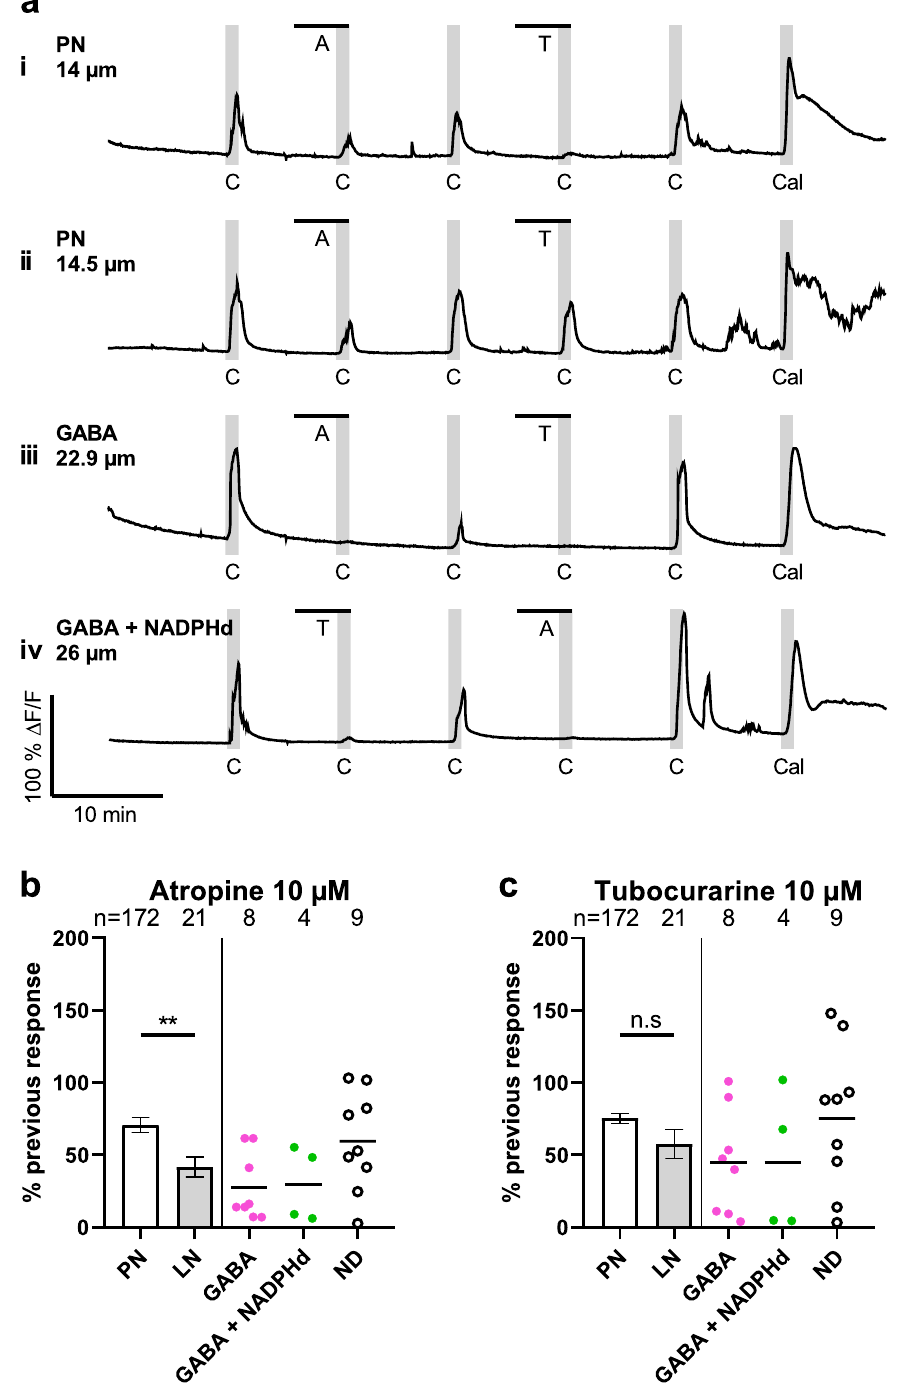
Figure 4. Reduction of carbachol-induced Ca 2+ transients by co-incubation with cholinergic antagonists. Neurons were stimulated by carbachol superfusion, with stimulus durations represented by the width of the vertical gray band. Antagonist exposure is shown as a black bar over the Ca 2+ traces ( a ). At 10 µM, carbachol elicited Ca 2+ transients, which were reduced when neurons were also exposed to 10 µM atropine or tubocurarine. Examples for Ca 2+ signals of PN and LN are shown in a i - iv , illustrating the magnitude of reduced transients in individual neurons. The PN in a i showed stronger inhibition by the nicotinic antagonist tubocurarine than by the muscarinic antagonist atropine, whereas the PN in a ii showed a converse response. Labeled LN (GABA and GABA + NADPHd) showed generally stonger inhibition by antagonists up to a complete response abolishment ( a iii & iv ). This reduction of Ca 2+ responses is summarized in b and c by normalization of amplitudes in the presence of antagonists to amplitudes prior to antagonist application. Bars show means ± s.e.m. of pooled PN and LN. Colored datapoints represent subtypes of individual LN. Atropine reduced responses of PN to 70.68% (± 5.29 s.e.m. n = 172), and to 41.64% (± 6.95 s.e.m. n = 21) for LN shown in b . These reductions were significantly different ( p = 0.0048, Mann–Whitney test). As shown in c, tubocurarine reduced responses of PN to 75.25% (± 3.39 s.e.m. n = 172), and to 57.74% (± 9.94 s.e.m. n = 21) for LN, which were not significantly different ( p = 0.0960, Mann–Whitney test). A = Atropine; C = Carbachol; Cal = Calcimycin; T =